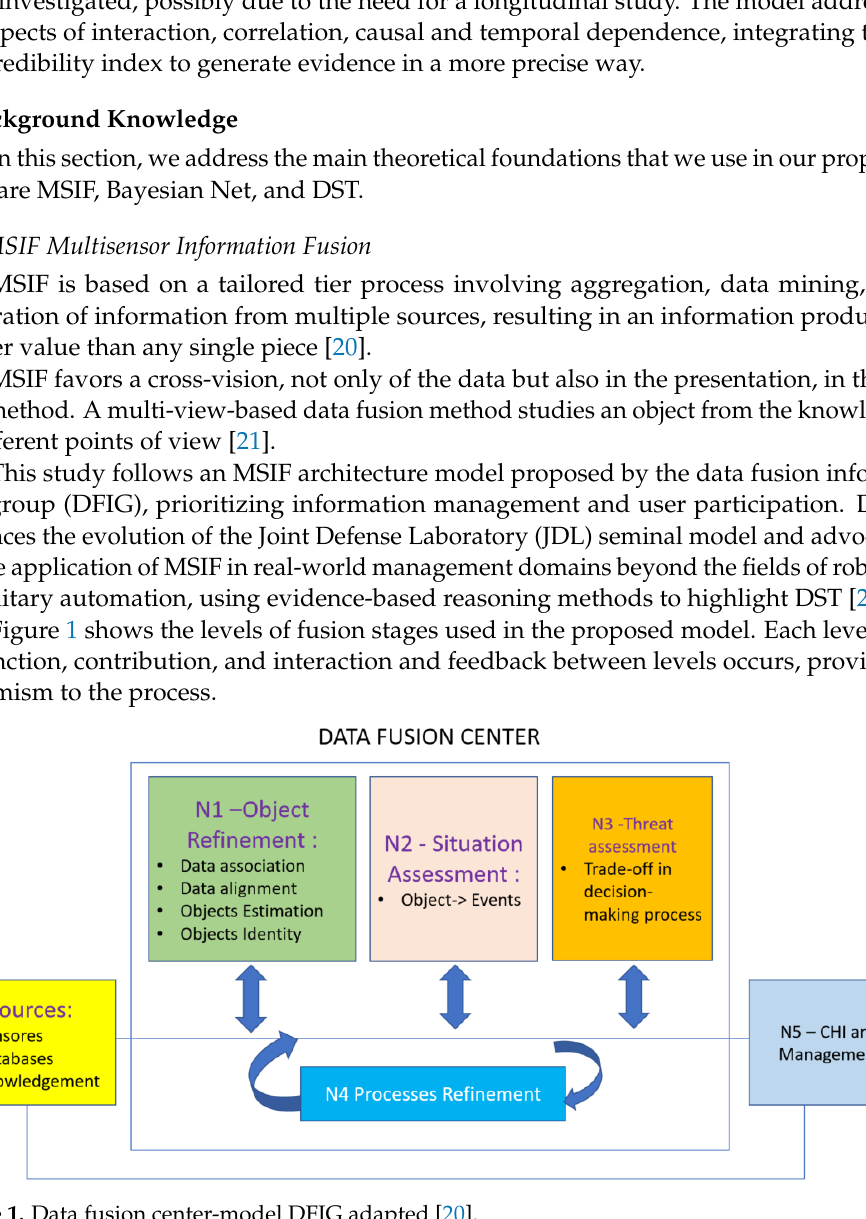
Figure 1. Data fusion center-model DFIG adapted